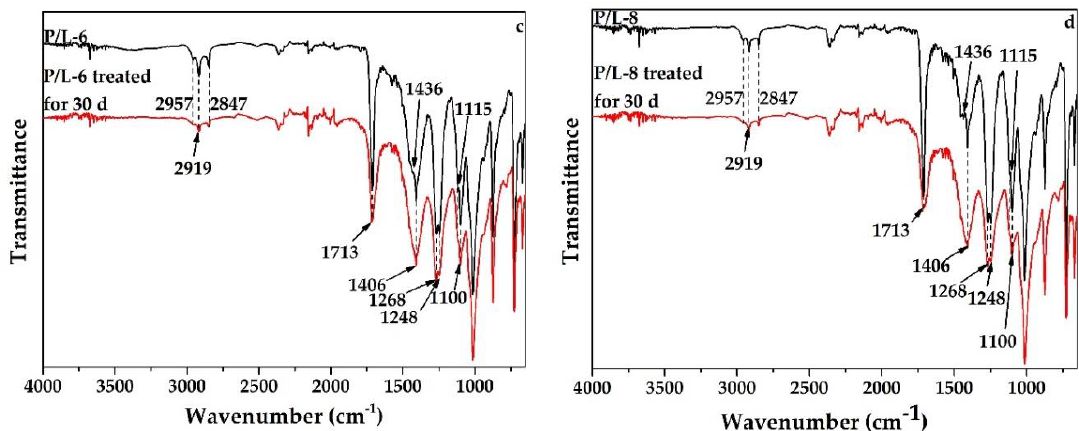
Figure 6. FT-IR spectra of samples before and after accelerated aging: ( a ) P / L, P / L-6, and P / L-8; ( b ) P / L before and after accelerated aging for 30 d; ( c ) P / L-6 before and after accelerated aging for 30 d; and ( d ) P / L-8 before and after accelerated aging for 30 d.